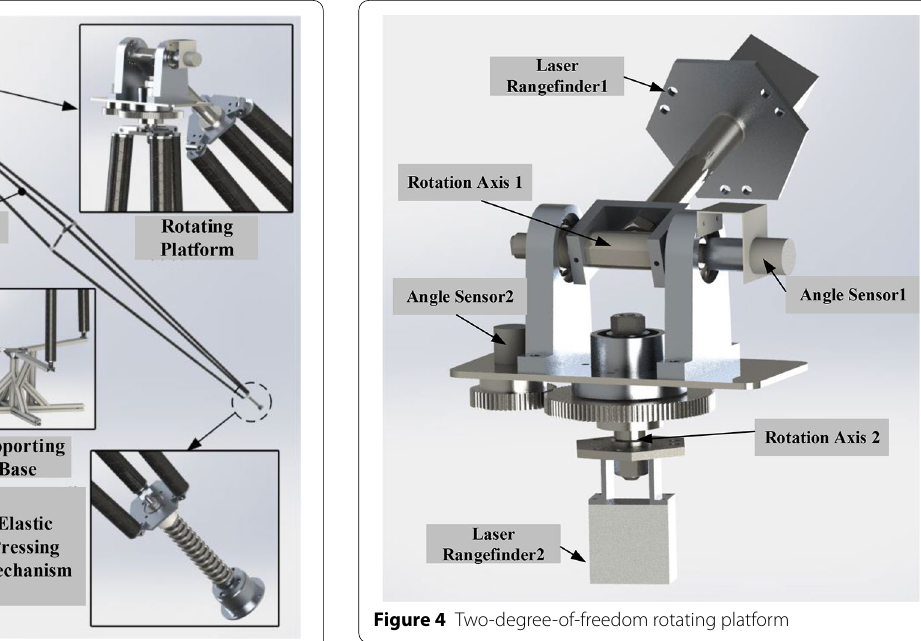
Figure 2 Model of the support mechanism